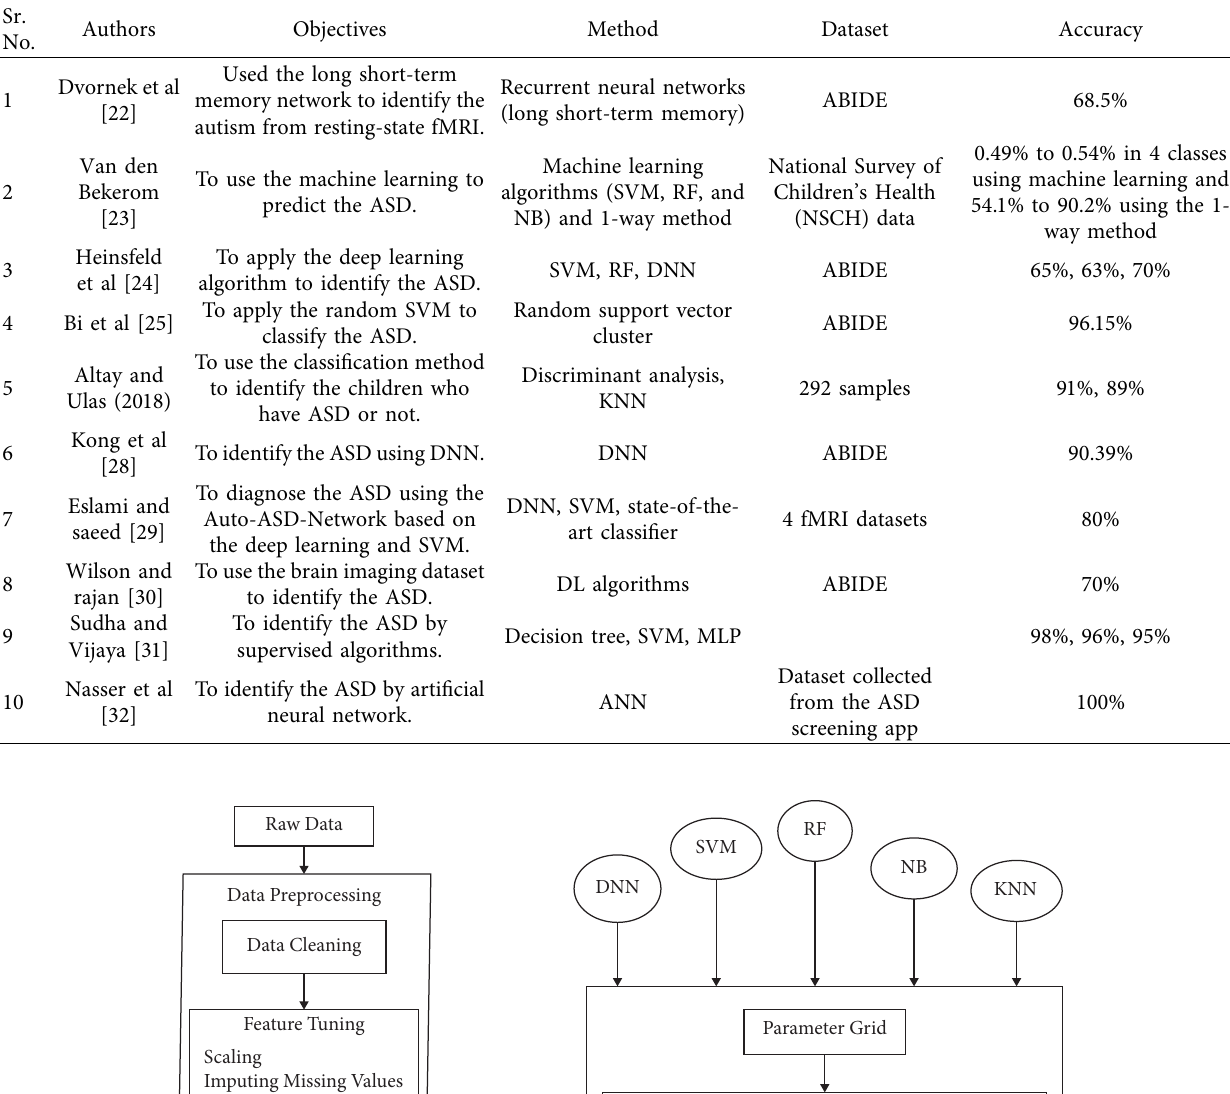
Table 1: Summary of related work.